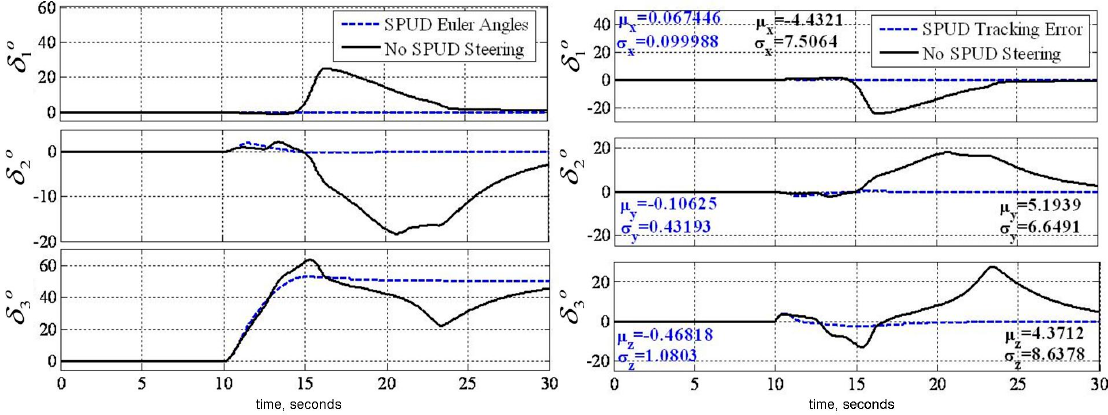
Figure 6. SIMULATION: Verifying the efficacy of SPUD. Mathematics 2018 , 6 , 1 FOR PEER REVIEW